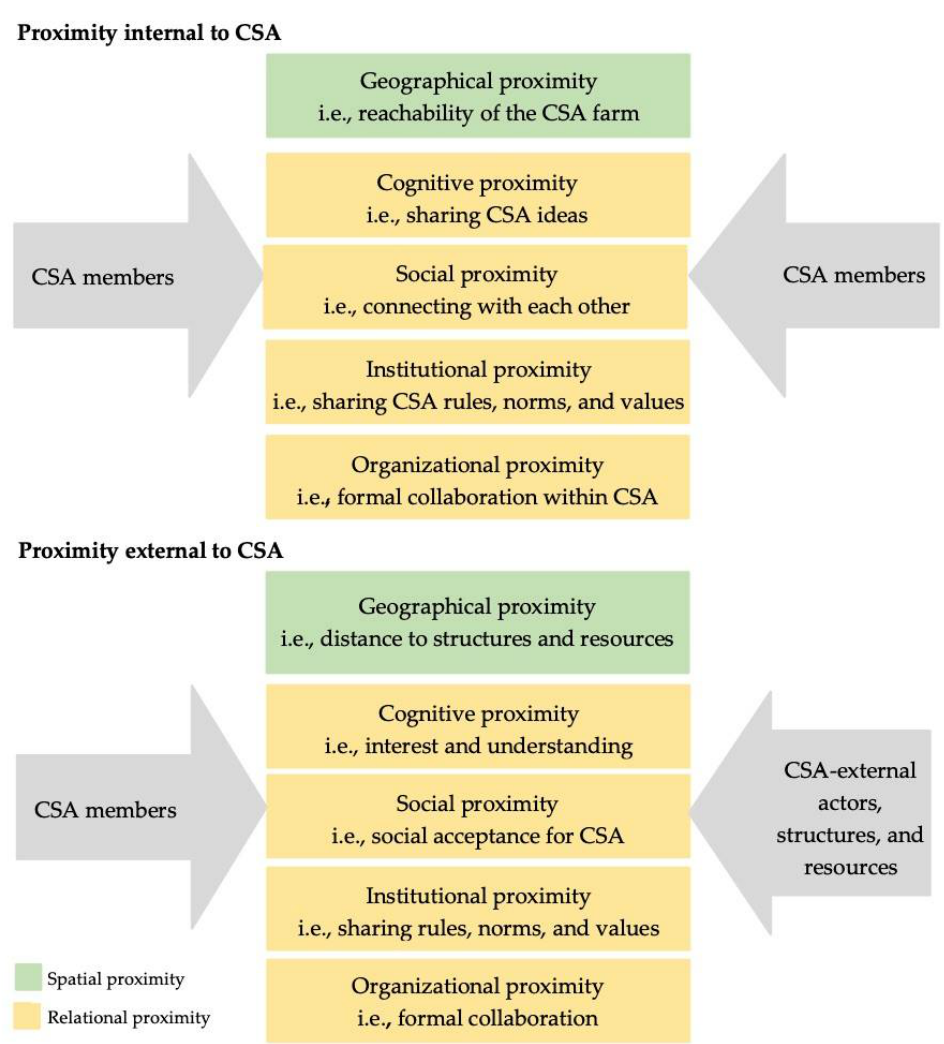
Figure 1. Operationalized spatial–relational proximity dimensions for the CSA (Community Supported Agriculture) context.